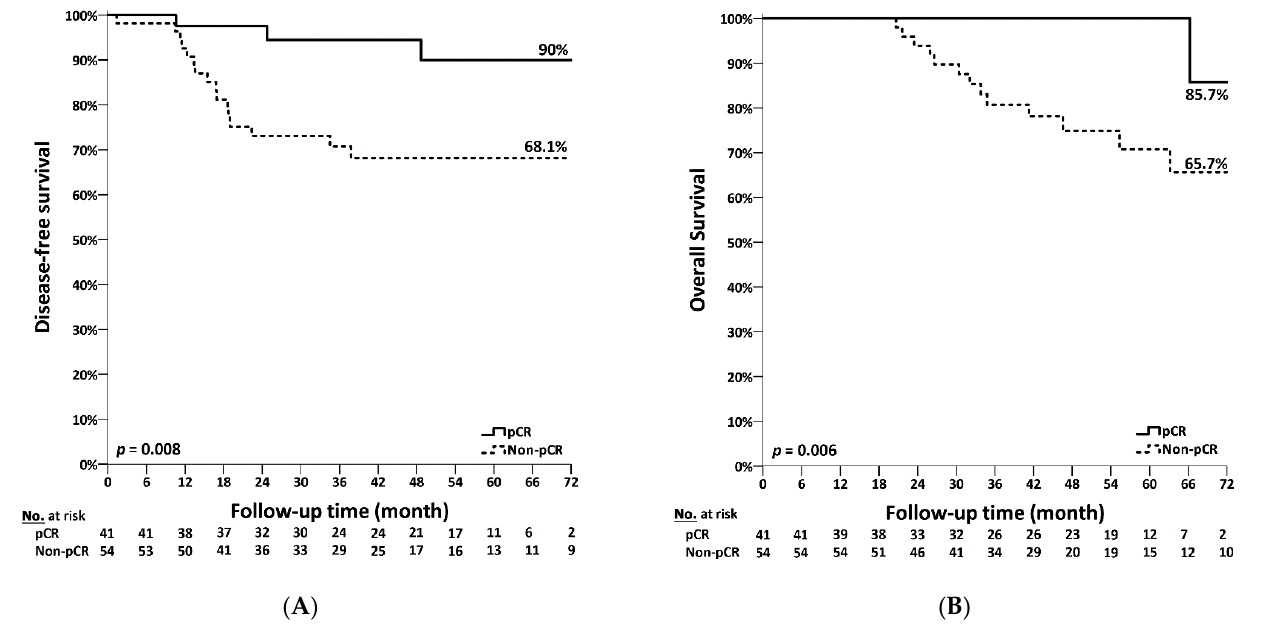
Figure 3. The survival curves of patients according to pathologic response after neoadjuvant chemotherapy, pCR (pathologic complete response) versus non-pCR. ( A ) Disease-free survival. ( B ) Overall survival.